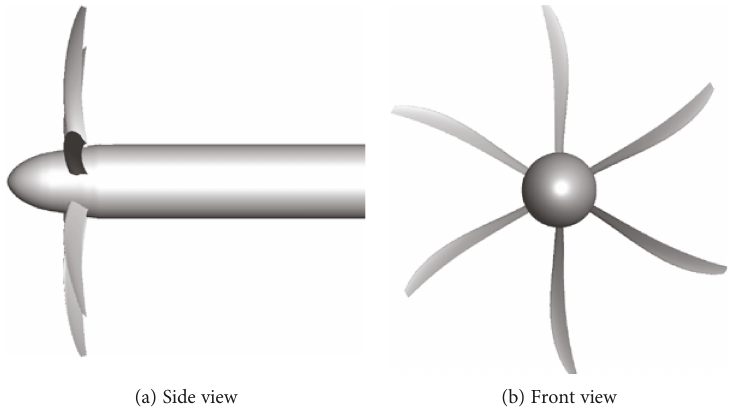
Figure 3: SRP numerical con fi guration and geometric layout.